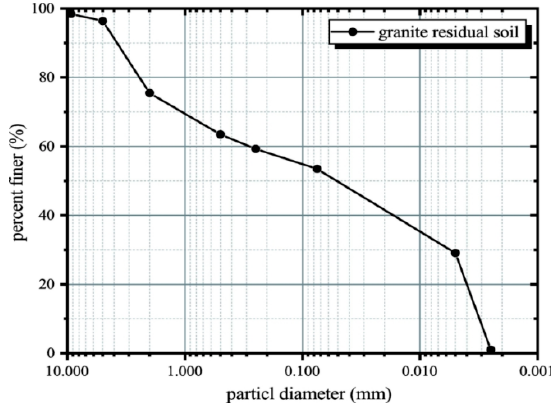
Figure 1. The grain composition curve of residual soils used in this study. Table 1. B a sic parameters of the tested residual soils.